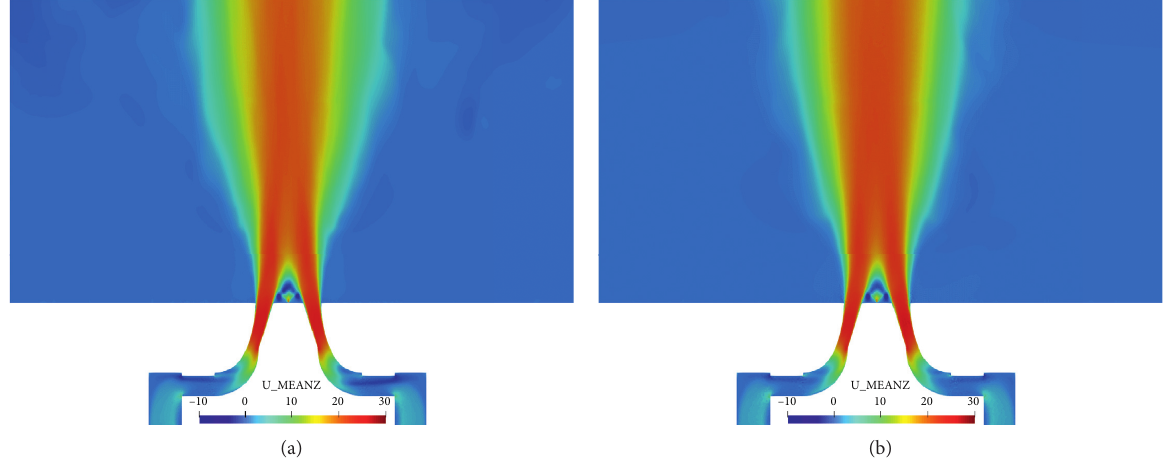
Figure 9: Mean axial velocity fields for cases A-R (a) and B-R (b) in the central vertical plane.